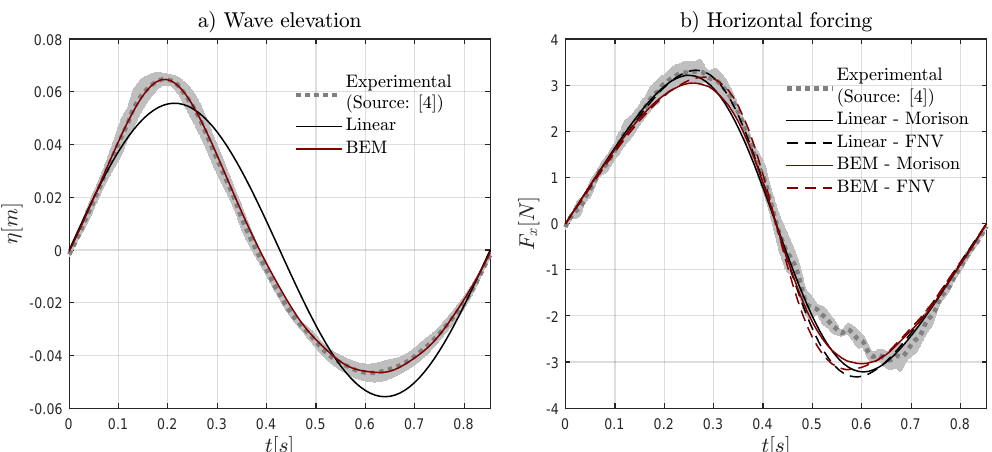
Figure 4. Comparison of a selection of computed: ( a ) wave elevation profiles, ( b ) loading models, with the superimposed experimental measurements reported in Grue and Huseby (2002) [4], for the case with wave steepness kH /2 = 0.31 and wave period T = 0.85 s (error bars are the standard deviation from the superimposition at